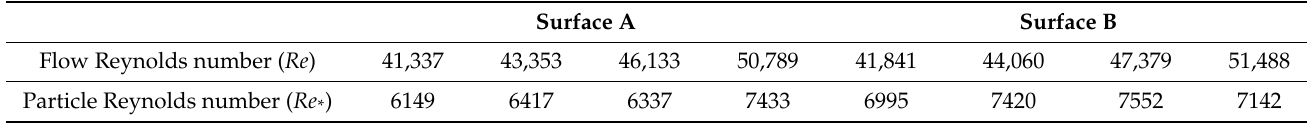
Table A7. Relevance of flow and particle Reynolds